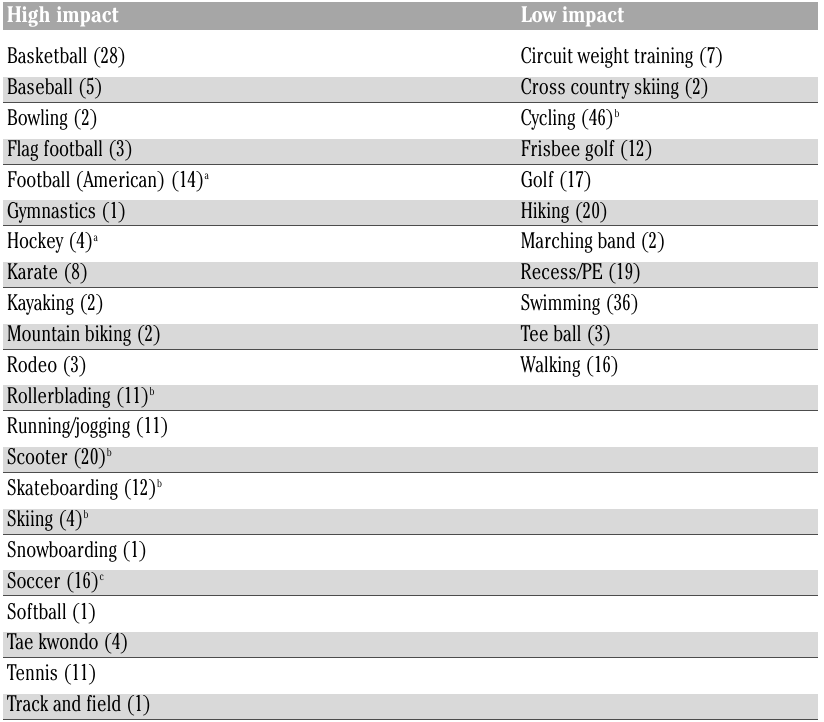
Tabella 1. Classificazione delle attività sportive secondo la National Hemophilia Foundation (USA). Tra parentesi il numero dei bambini inclusi nello studio 16 che la prati -